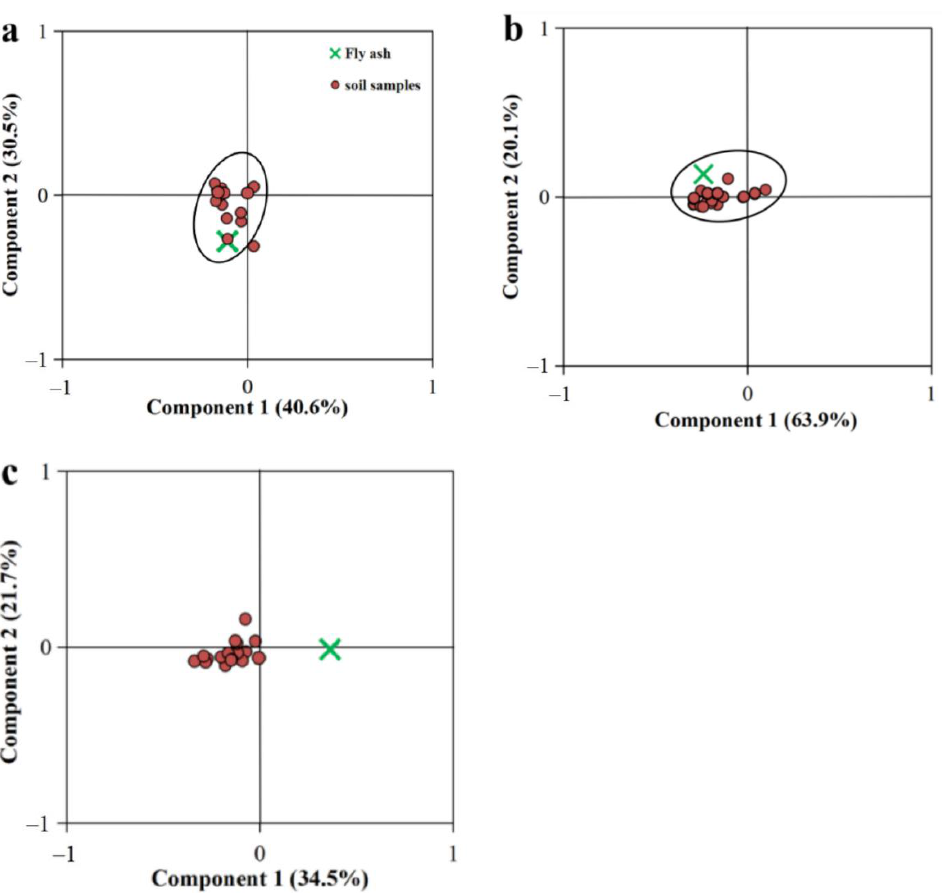
Figure 4. Principal component analysis score plots for PCN ( a ), PCB ( b ), and PCDD/F ( c ) homologue concentrations in the soil and fly ash samples.